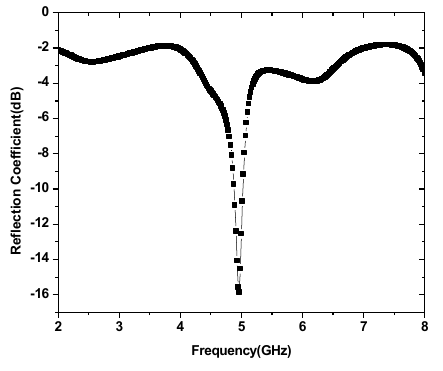
Figure 11: Reflection coefficient of 2×2 MTPAA at 4.98 GHz